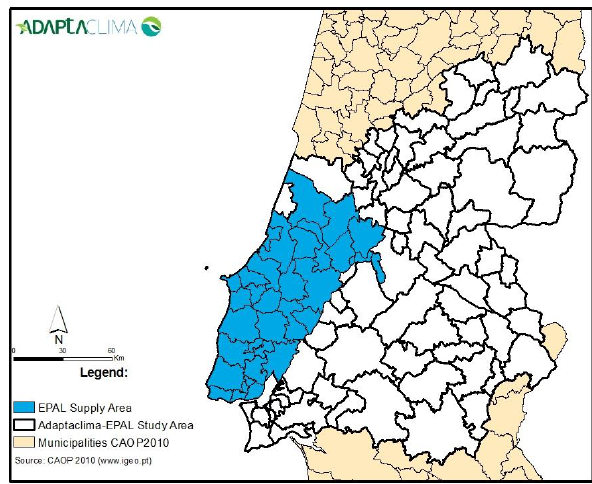
Figure 1 - Study Area. Source: Adaptaclima-EPAL project report (2011). Figure 1. Study Area. Source: Adaptaclima-EPAL project report 2. MATERIALS AND METHODS Local scenarios 1 of water use until the end of the century were explored, not only for the EPAL system, but also for other sectors, namely agriculture or industry. We used the four IPCC SRES (A1, A2, B1 and B2) (IPCC, 2000) to produce climate and hydrological scenarios for the project. The IPCC SRES sets up changes in population, economic growth, technology, energy consumption, and greenhouse gas emissions (IPCC, 2007; Shen et al., 2008). Several studies have produced water consumption scenarios for Europe for the 21 st century based on SRES (e.g. Seckler et al., 1998; Märker et al., 2003; Flörke, 2005; Alcamo et al., 2007; Bates et al., 2008; Shen et al., 2008; Kok et al., 2009). 1 The terminology local scenario was adopted for our results while for IPCC scenarios the term SRES was used. At the national scale, there are also INE’s population projections.